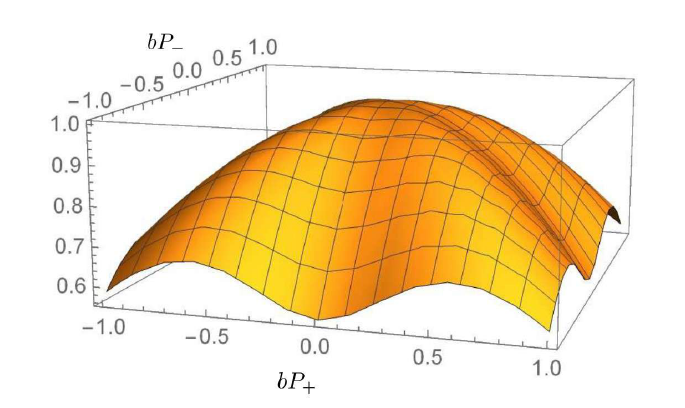
Figure 18. The 3D-profile of the anisotropy velocity (173) with b α / b =